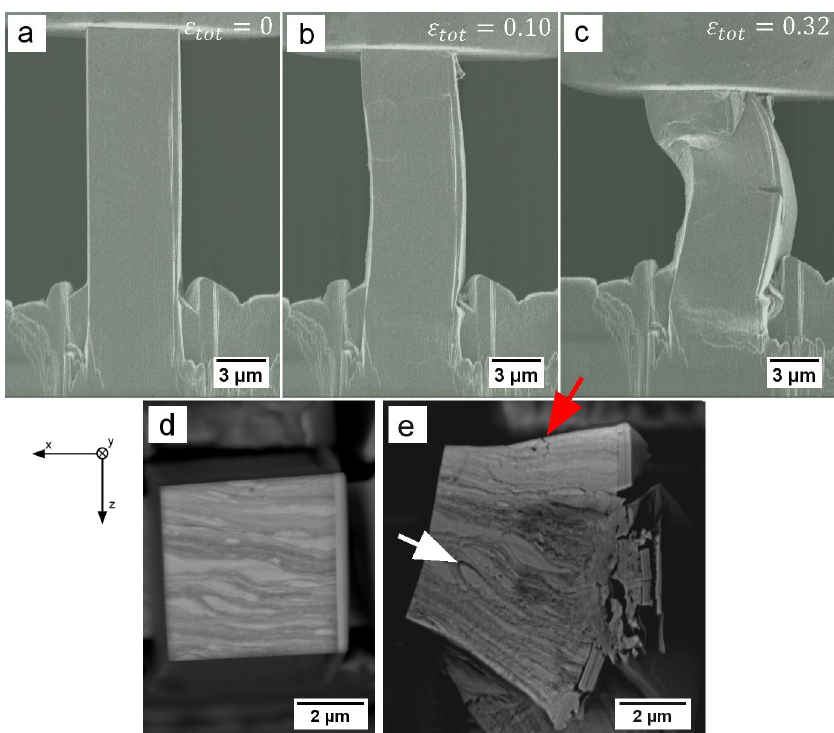
Figure 4. Compression steps of sample 2 ( a ) at contact, ( b ) at a strain of 0.10 during first loading and ( c ) at a strain of 0.32 during second loading. Top view of sample 2 ( d ) before and ( e ) after compression. The white arrow indicates detachment of different phases. The red arrow indicates trans-granular cracking.